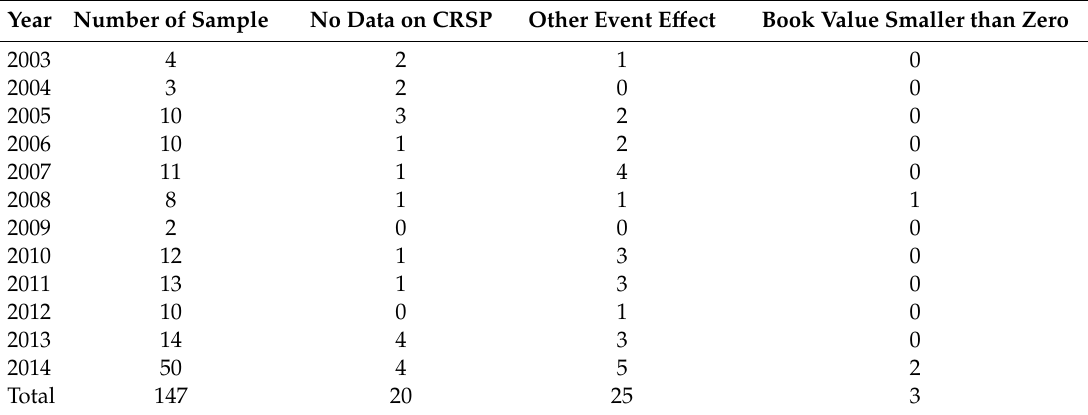
Table 2. Sample selection criteria for short-term.